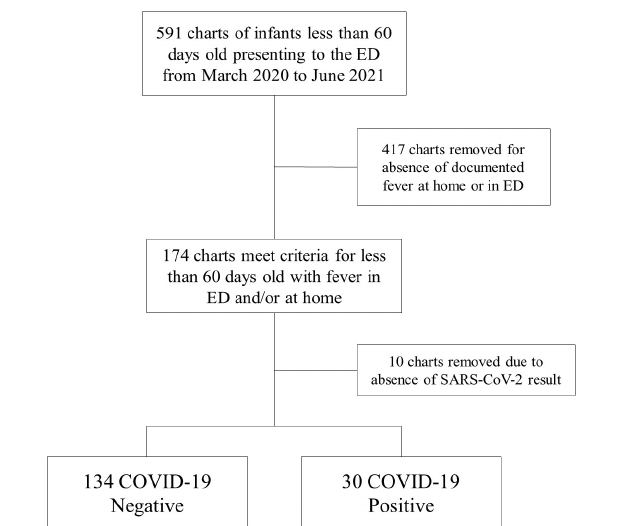
Figure . Flow diagram showing the selection of patients for inclusion in study.